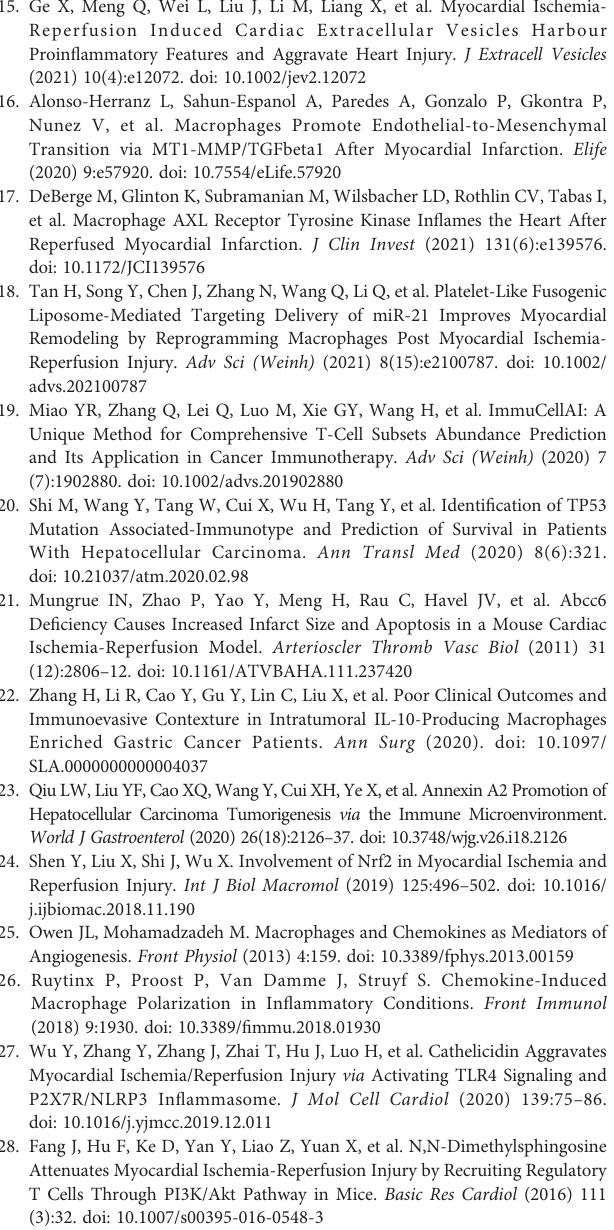
Supplementary Figure 1 | The expression of Nrf2 in heart muscle tissue or cells underdifferentconditions. (A) TheexpressionofNrf2mRNAinmousemyocardiumunder different conditions according to the dataset of GSE160516. Control, Sham-operated group;IR6h/IR24h/IR72h,reperfusionfor6hours/24hours/72hoursafterischemiafor30 minutes. (B) The expression of Nrf2 mRNA in rat cardiomyocytes H9C2 under different conditions according to the dataset of OEP002796. Hypoxia, hypoxia for 30 minutes. HR6h/HR24h, reperfusion for 6 hours/24 hours after hypoxia for 30 minutes. (C) Typical image of anti-Nrf2 immunohistochemical staining in mouse myocardium under different conditions. Sham, Sham-operated group; Ischemia, ischemia for 30 minutes; IR6h, reperfusion for 6 hours after ischemia for 30 minutes. (D) Supplementary Figure 2 | Percentage of immune cell in fi ltration in the second/ third layers of ImmuCellAI-mouse analysis. (A) Schematic diagram of ImmuCellAI-